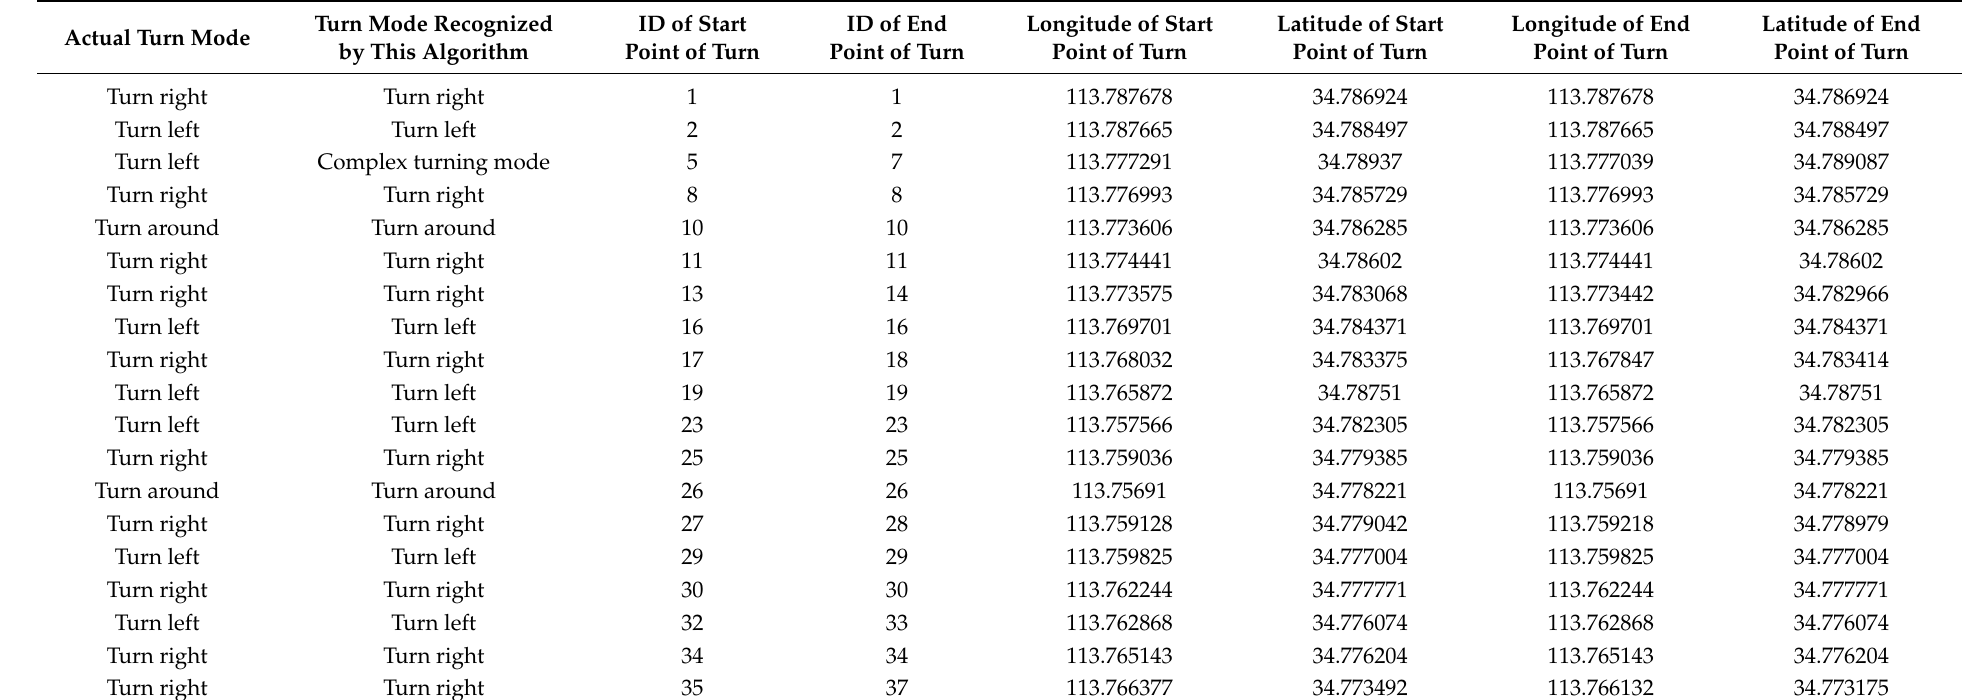
Table 6. Turning modes recognized by this